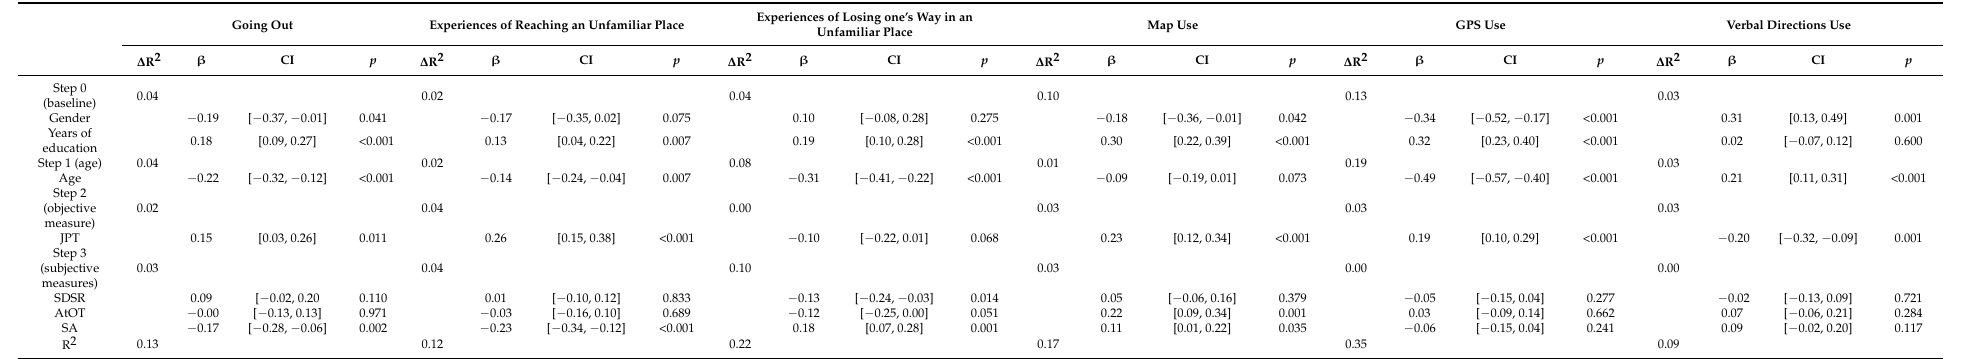
Table 2. Regression models for everyday orientation experiences (going out, the experience of reaching an unfamiliar place, the experience of losing one’s way in an unfamiliar place) and navigation aid use (map, GPS, and verbal directions